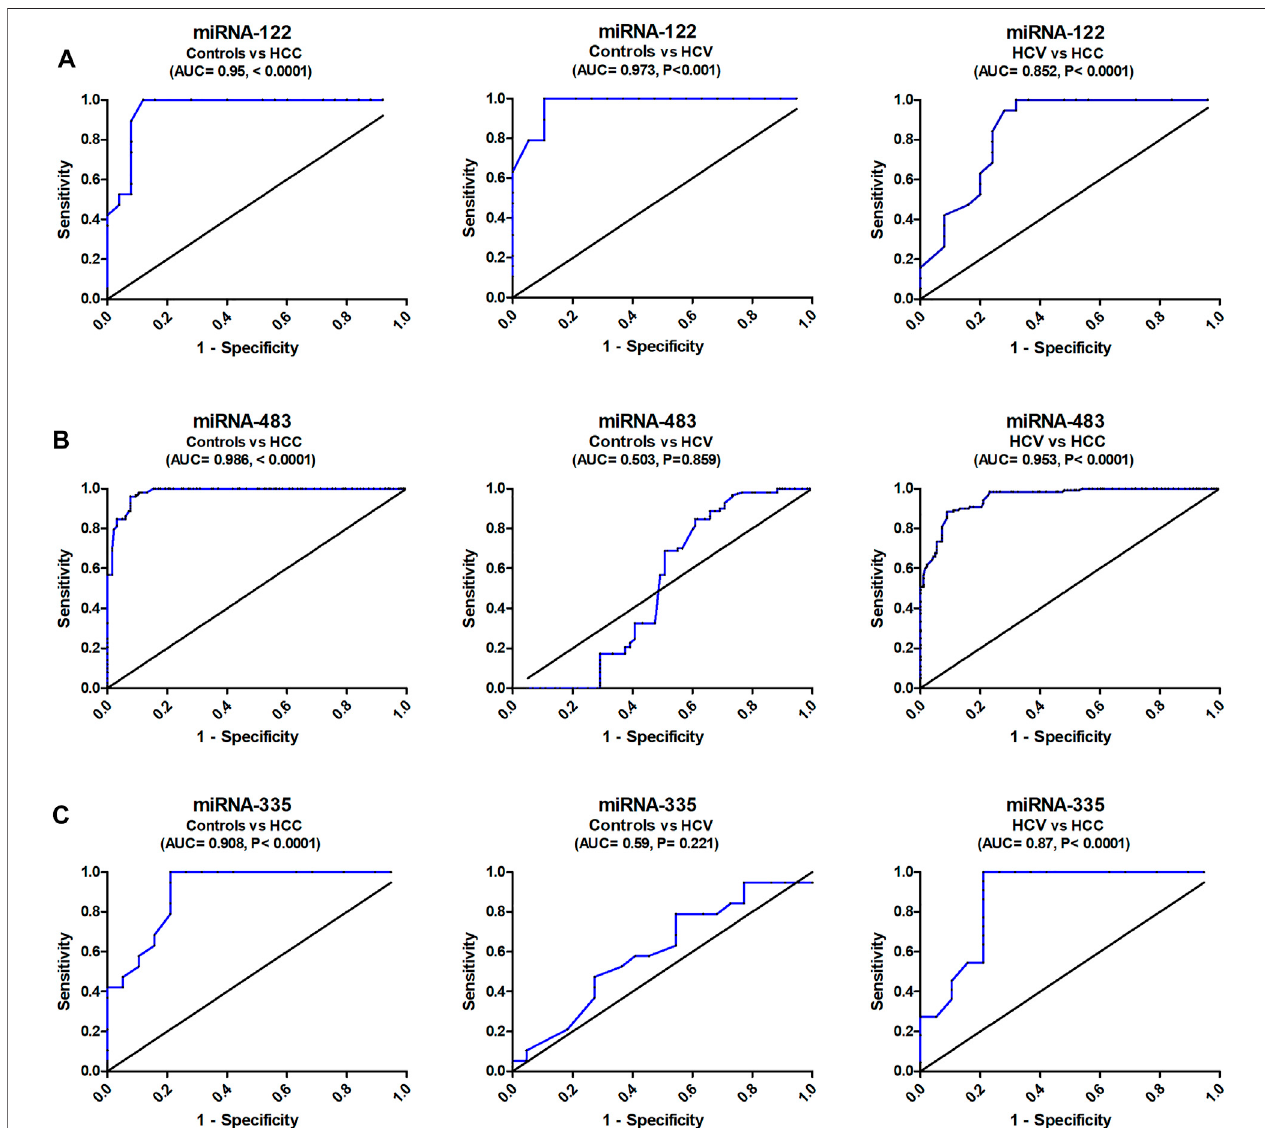
FIGURE2| DiagnosticaccuracyofserummiRNA-122,miRNA-483,andmiRNA-335.StudyoftheROCcurveofserummiRNA-122,miRNA-483,andmiRNA-335 to differentiate the studied types, HCC ( n = 90) and HCV ( n = 90), from controls ( n = 60).